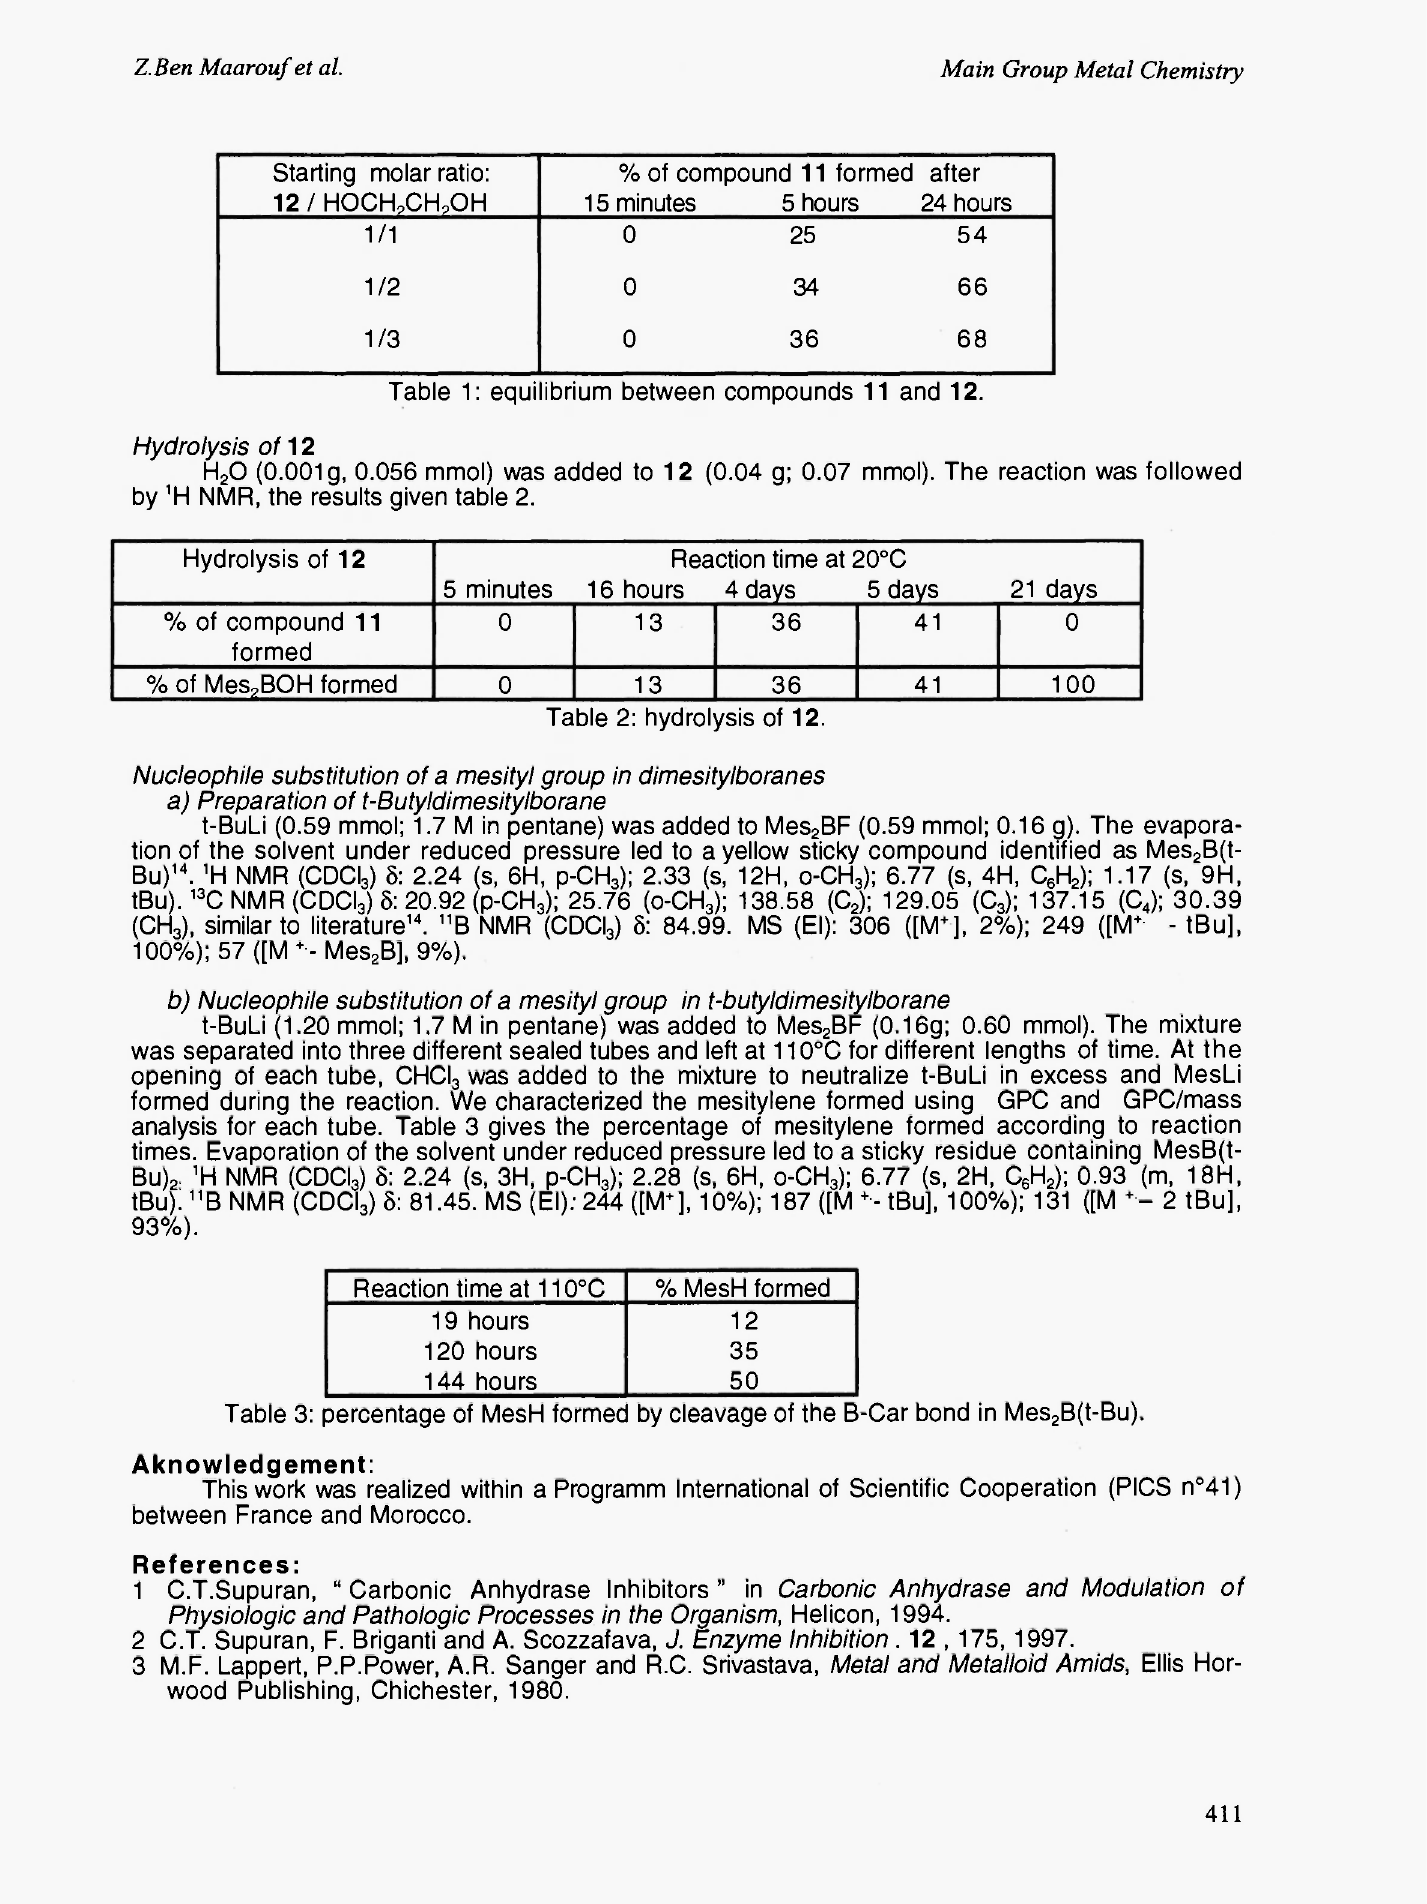
Table 1: equilibrium between compounds 11 and 12.